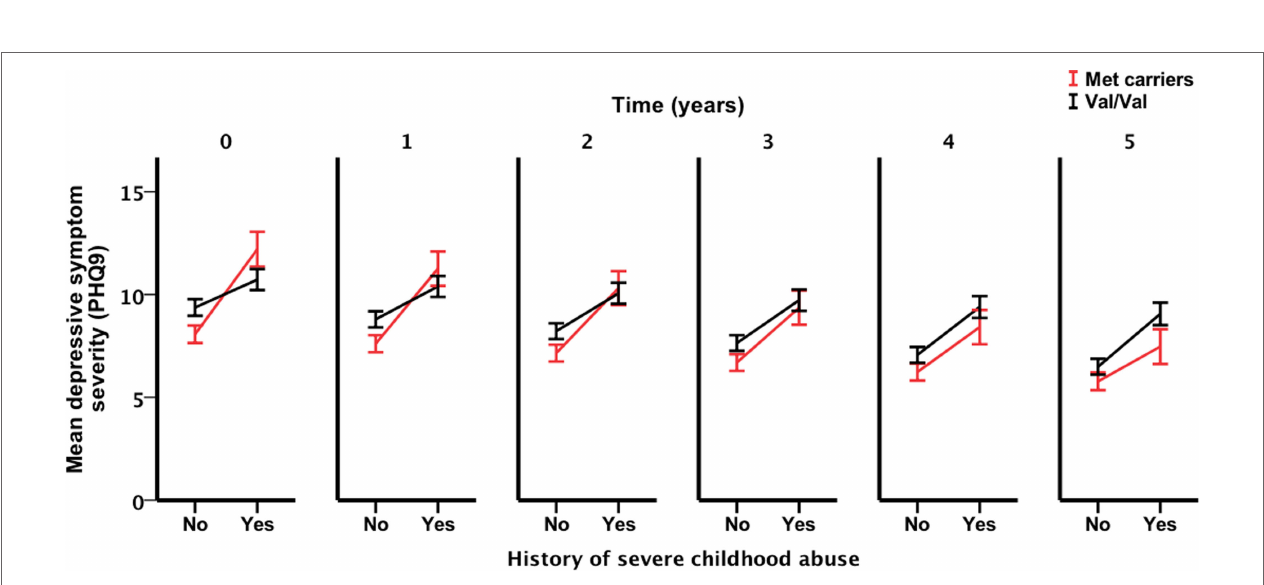
FigUre 3 | interaction effect of severe child abuse and BDNF rs6265 genotype by time point . Time point zero represents baseline, measured annually from baseline. Points and associated SE bars represent predicted values based on the final covariate-adjusted model. PHQ-9 = Primary Care Evaluation of Mental Disorders Patient Health Questionnaire-9.